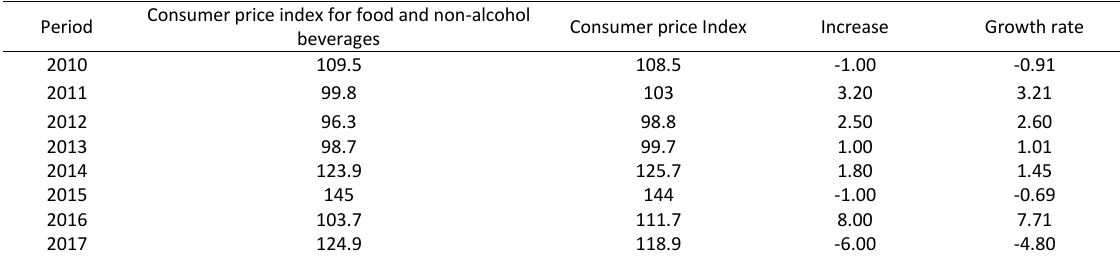
Table 3: Consumer price indices and households’ expenditures on food in Ukraine in 2010-2017 in percentage (State Statistics Service of Ukraine, 2018b; State Statistics Service of Ukraine, 2018f; State Statistics Service of Ukraine, 2018c) Period